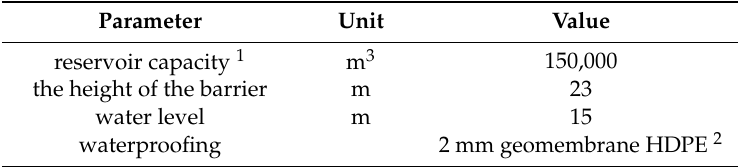
Table 3. Structural and operational parameters of the lower hydropower plant.